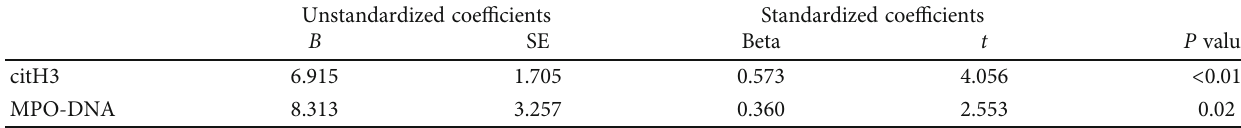
Table 2: Multiple linear regression analysis of citH3 and MPO-DNA a ff ecting serum occludin levels in AIS patients at day 3 after treatment.